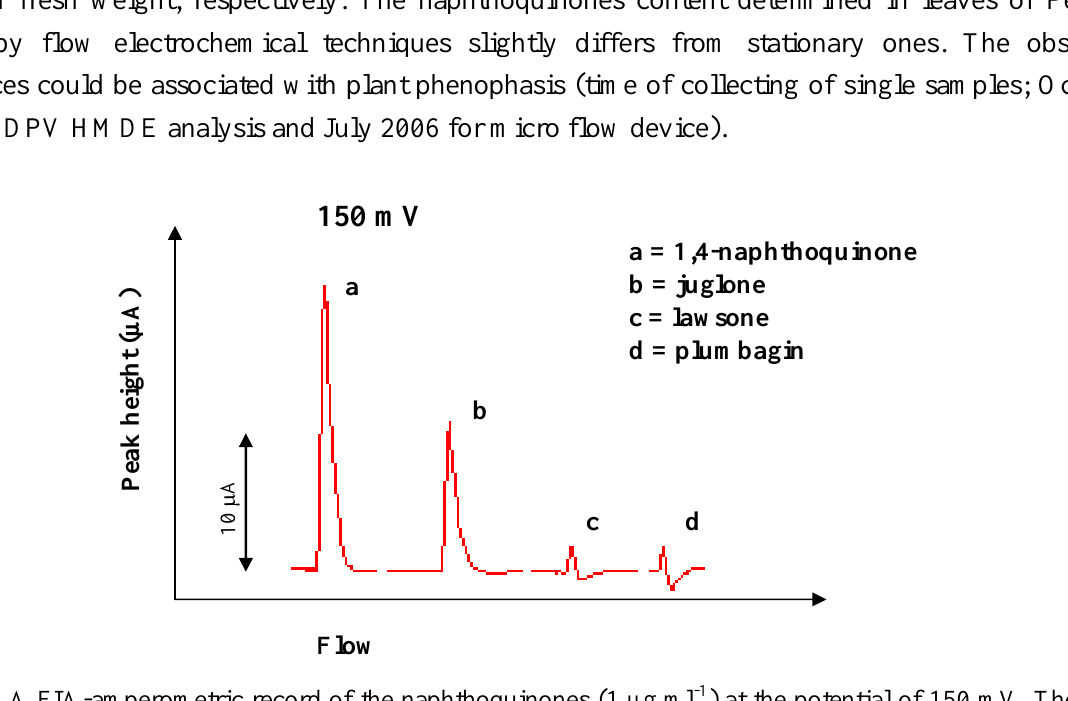
Figure 5. A FIA-amperometric record of the naphthoquinones (1 µg.ml -1 ) at the potential of 150 mV. The flow rate of the electrolyte (0.2 M phosphate buffer, pH 5.5) was 0.5 ml.min -1 . The sample (5 µl) was injected manually. The working electrode was made from glassy carbon, auxiliary carbon electrode and referent hydrogen palladium electrode. For other details see “Materials and Methods”